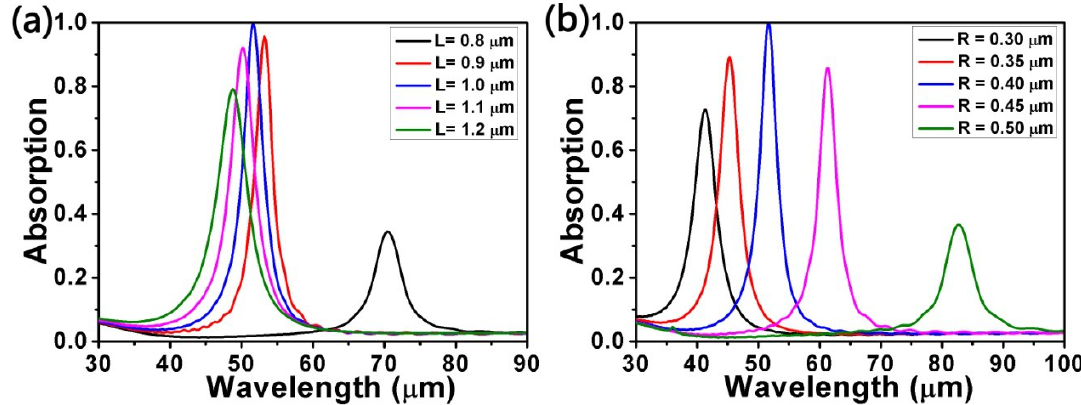
Figure 3. Absorption spectra for ( a ) different lengths L of the square and ( b ) different radii R of the circle. Other parameters remain fixed.